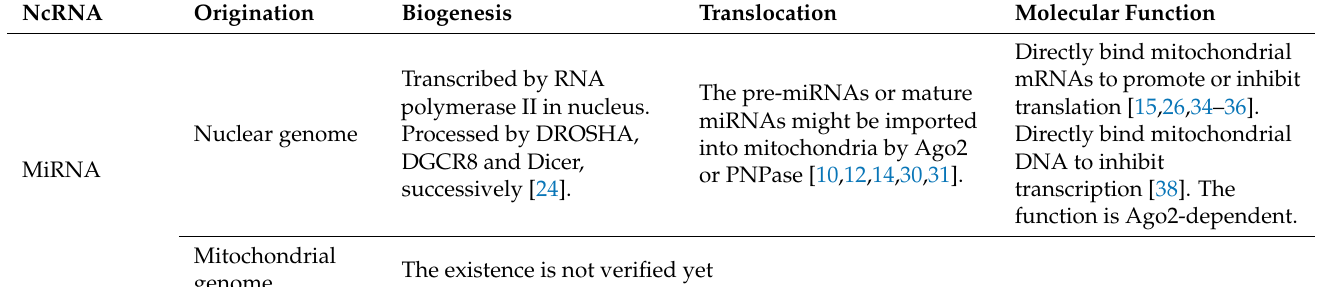
Table 3. Biogenesis, translocation, and molecular function of mitochondrial